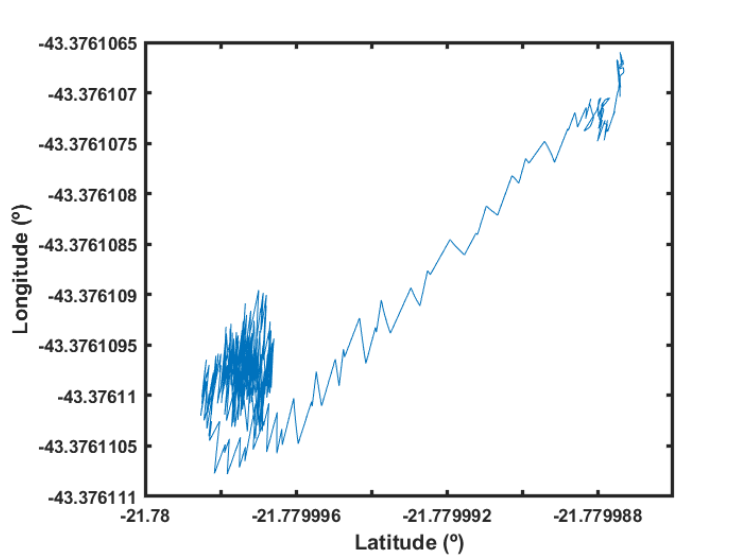
Figure 24. Position